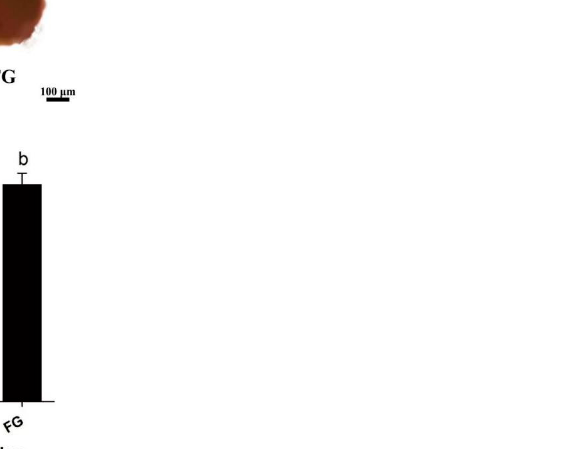
Figure 4. Stage-dependent expression of igf3 in developing E. coioides follicles. ( A ) Morphology of E. coioides follicular at different stages of maturation. PG—primary growth; PV—previtellogenic; EV—early vitellogenic; MV—midvitellogenic; FG—full-grown. ( B ) Expression of igf3 mRNA during different stages of ovarian follicle development. Different letters (a and b) indicate significant dif- ferences.